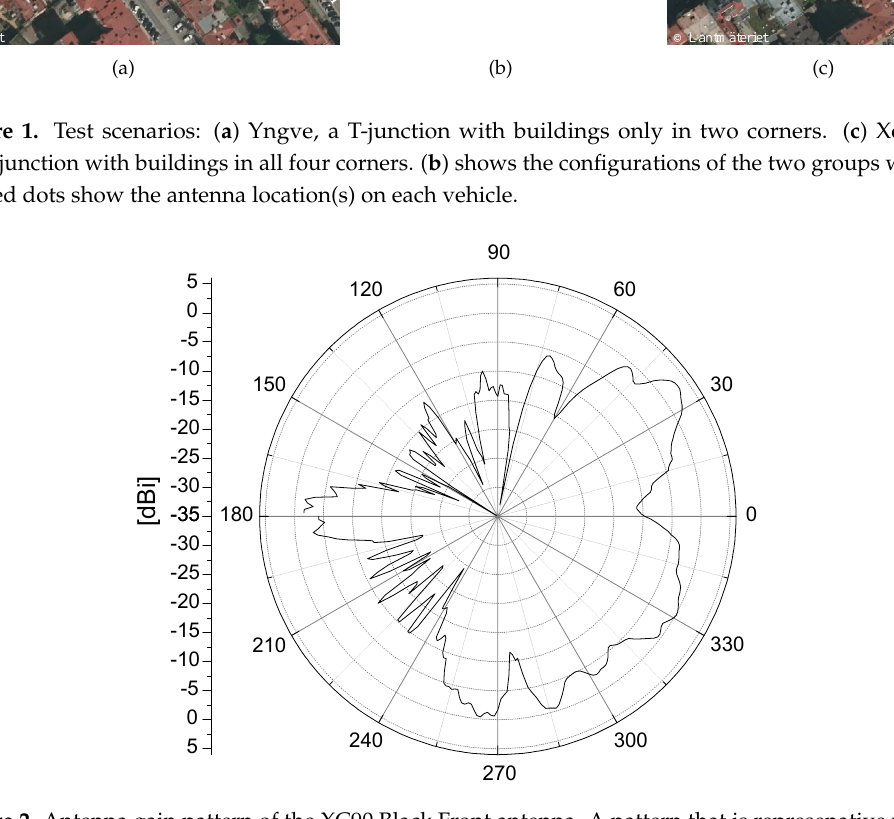
Figure 2. Antenna gain pattern of the XC90 Black Front antenna. A pattern that is represenative when mounting 5.9GHz antennas on vehicles that are far from omni-directional. The front of the car is in the direction of zero degrees.